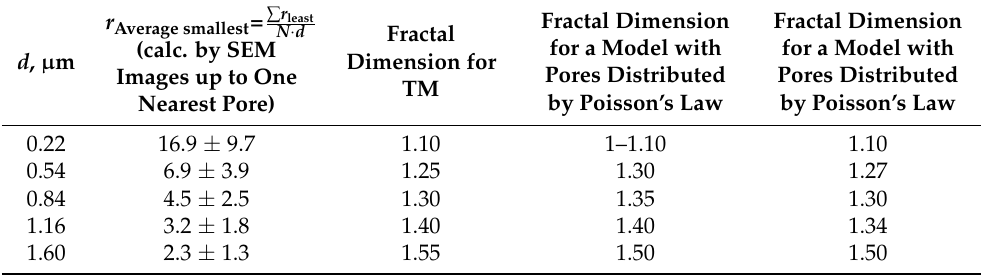
Table 6. Fractal dimension for TM surface pore distribution and TM computer models (regular network and Poisson distribution) at n = 4 × 10 6 cm − 2 .